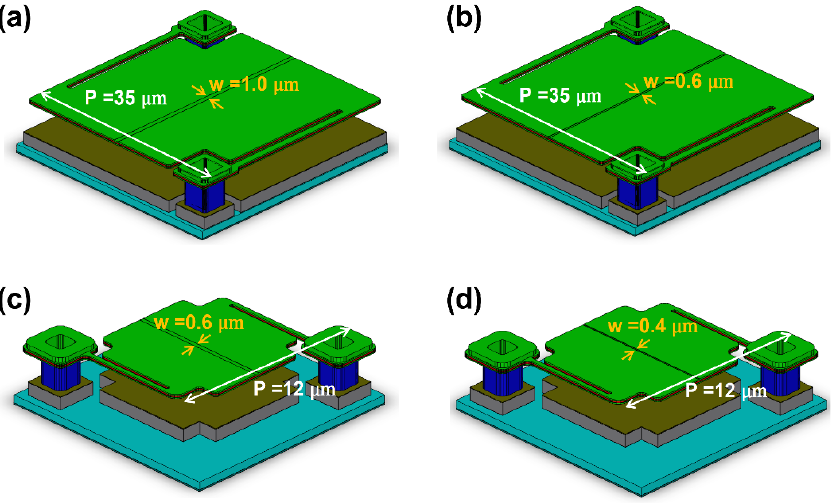
Figure 2. Schematic 3D views of the four different types of a-Si microbolometer unit pixels. ( a ) P35- S10, ( b ) P35-S06, ( c ) P12-S06, and ( d ) P12-S04.